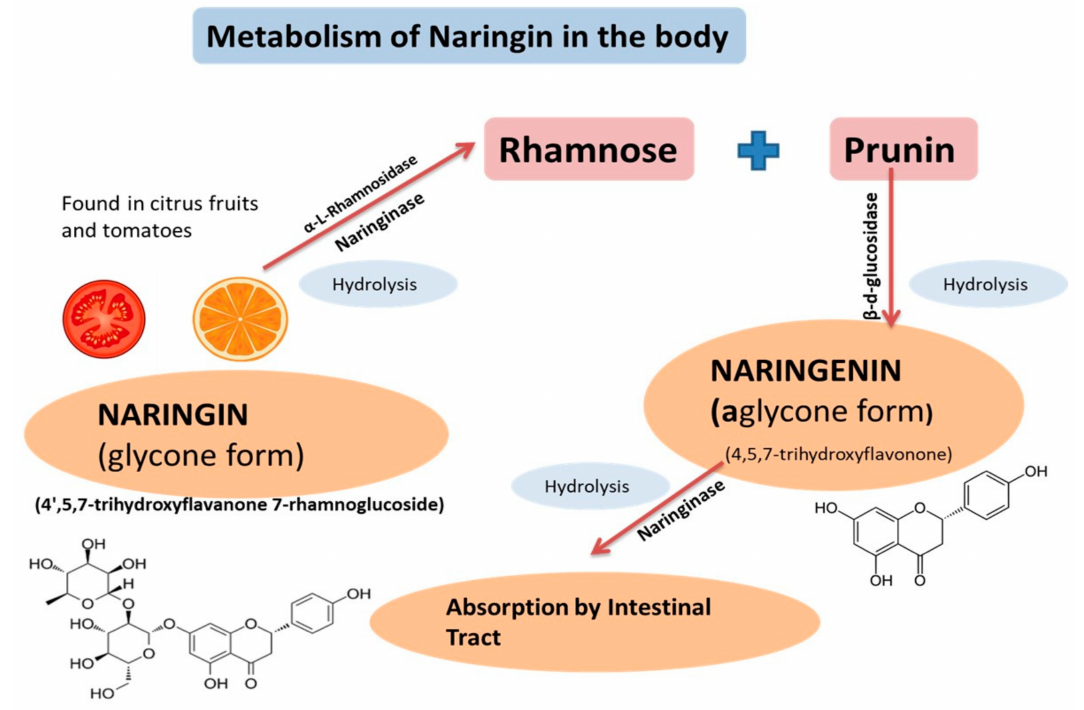
Figure 1. Naringin is hydrolyzed by naringinase and α -L-rhamnosidase into prunin and rhamnose. With the help of β -d-glucosidase, prunin then is hydrolyzed into “Naringenin,” which is absorbed into the intestinal tract after being hydrolyzed by